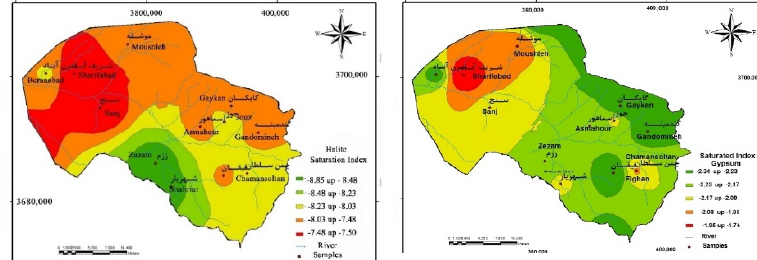
Fig. 1. The saturation Index map of Dolomite and Calcite of the study area